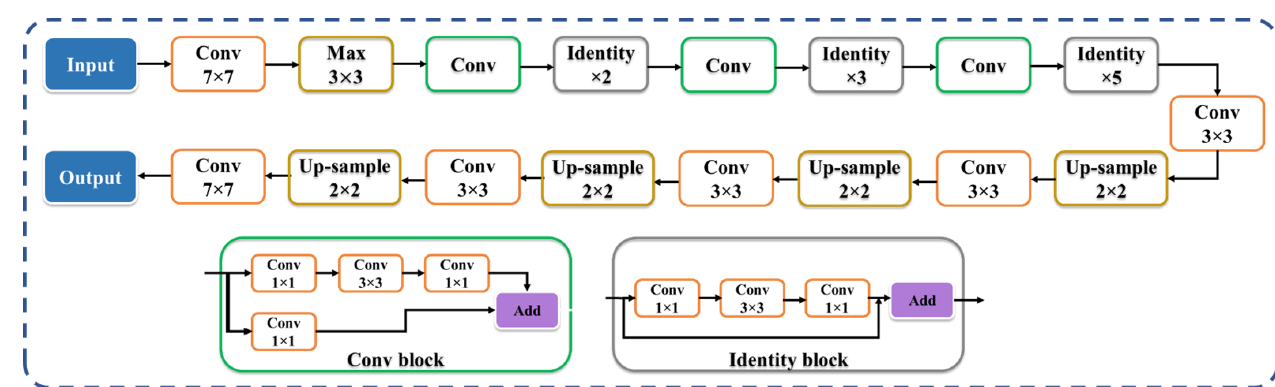
Figure 6. VGG-SegNet HDL model’s architecture. Figure 6. VGG ‐ SegNet HDL model’s architecture. Figure 6. VGG ‐ SegNet HDL model’s architecture.